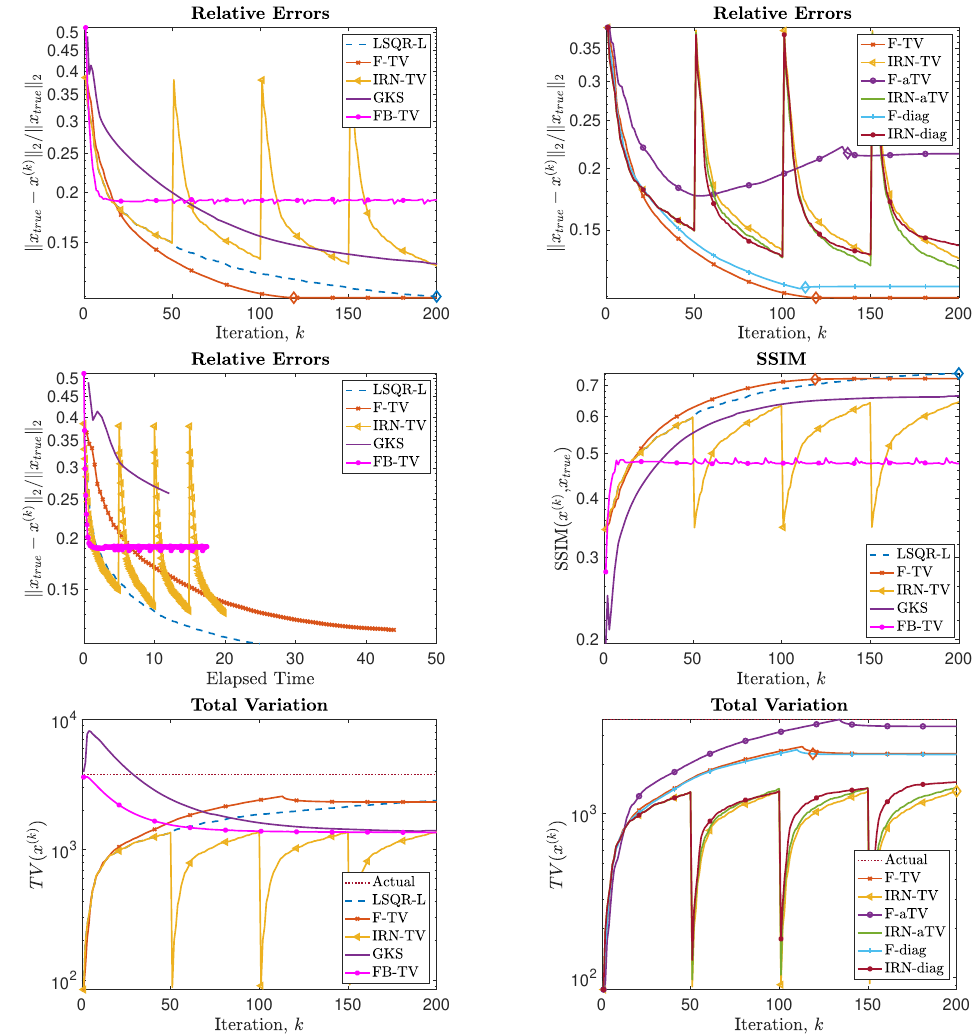
Figure 8. Experiment 2. ( Top row ): history of the relative error norms, comparing F-TV, F-aTV, F-diag, FBTV, and LSQR-L. Diamond markers indicate the iteration at which the stopping criterion (31) is satisfied. ( Second row , left ): progress of the F-TV, LSQR-L, FBTV, GKS and IRN-TV relative errors versus elapsed computational time. ( Second row , right ): SSIMs values versus iteration number for F-TV, LSQR-L, FBTV, GKS and IRN-TV. ( Bottom row ): history of the total variation of the reconstructions computed by each